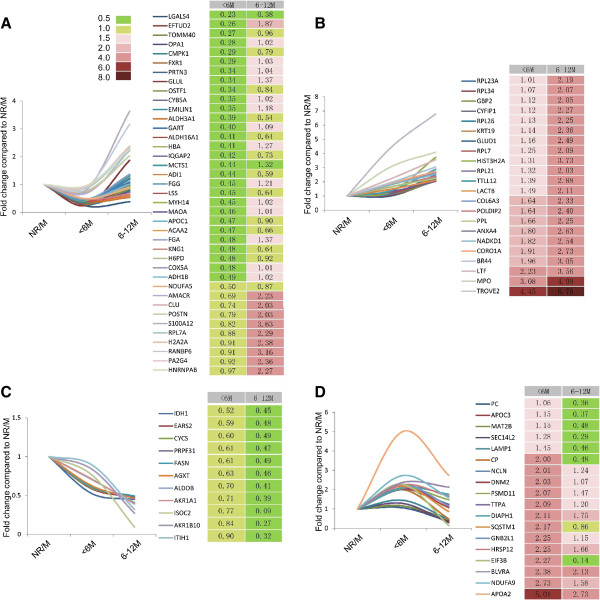
Alternation tendency of proteins in R/M≤6months group and R/M6-12months group comparing to the NR/M group. (A) The proteins which are decreased in the R/M≤6months group, but increased in the R/M6-12months group comparing to the NR/M group; these proteins are mostly related with glycolysis and protein synthesis. (B) The proteins which are highly expressed in both R/M≤6months group and R/M6-12months group comparing to the NR/M group; these proteins are mostly involved in protein synthesis process. (C) The proteins which are lowly expressed in both R/M≤6months group and R/M6-12months group comparing to the NR/M group; these proteins are mostly related to the amino acid metabolic process. (D) The proteins which are increased in the R/M≤6months group, but decreased in the R/M6-12months group comparing to the NR/M group; these proteins are involved in multiple signaling pathways.